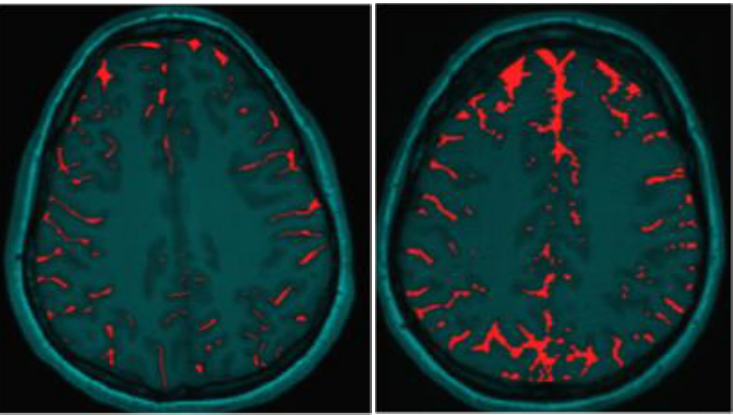
Figure 1. Illustration of increased Sulcal Volume in the brain of Women Soccer players before ( left image) and after ( right image) concussive events. The red coloring indicates the Sulcal volume.